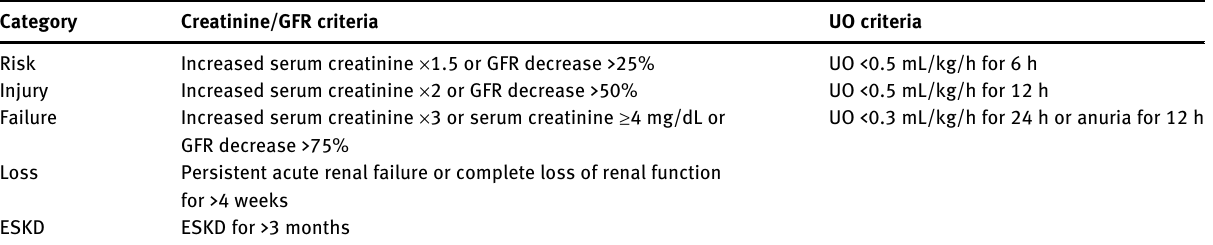
Table  : RIFLE criteria.